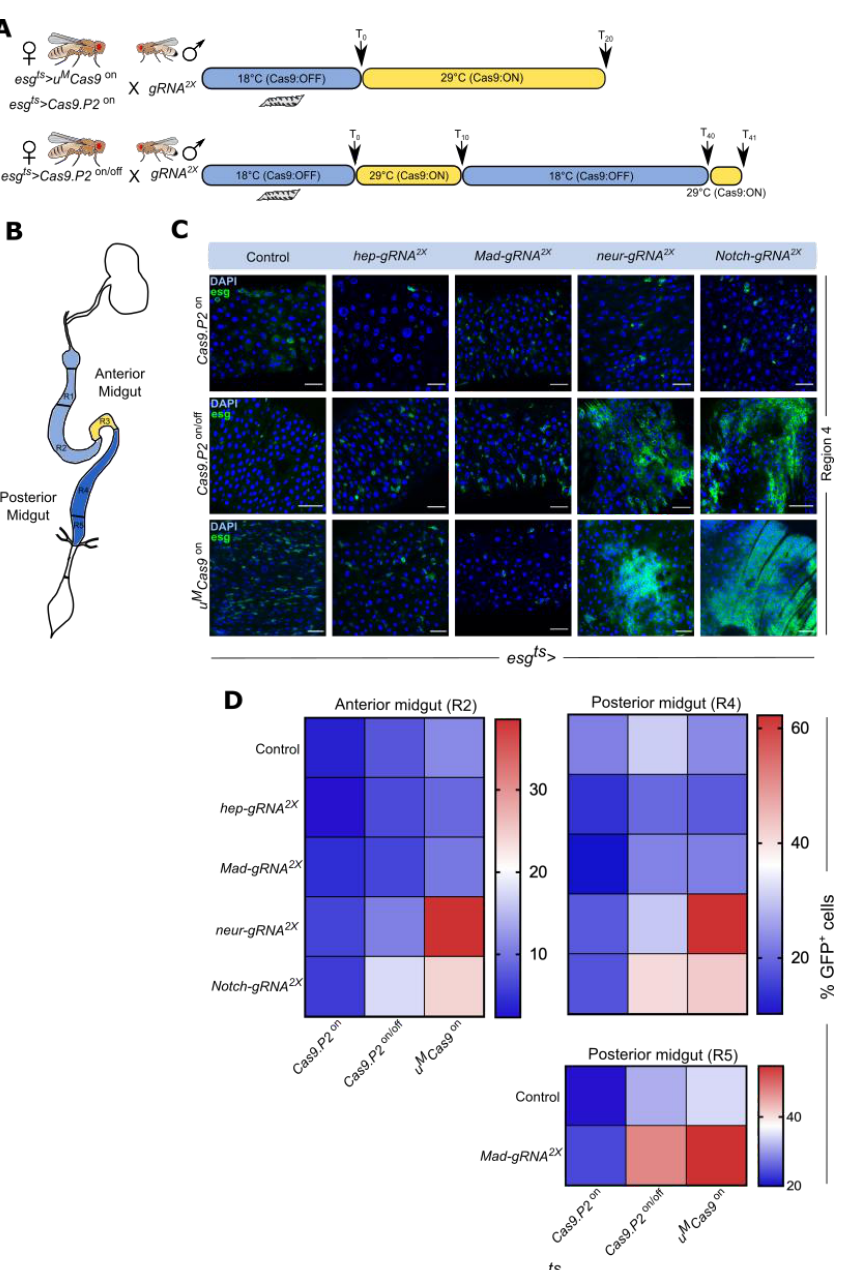
Figure 3. Both Cas9.P2 on/off and u M Cas9 on are effective at inducing intestinal stem cell derived tumors. ( A ) Schematic representation of the timepoints used for experiments. Female flies expressing either Cas9.P2 on or u M Cas9 on were crossed to male flies expressing different gRNAs . The cross was main- tained at 18 °C and the progeny were raised under these conditions during their development. After adult progeny emerged (T 0 ), they were shifted to 29 °C continuously for 20 days to induce the esg ts expression system, which allows for both Cas9 and gRNAs to be expressed in ISCs/EBs. Since high expression of Cas9.P2 is toxic, we also devised an on/off strategy ( Cas9.P2 on/off ), whereby adult prog- eny were initially shifted to 29 °C for 10 days (T 10 ), then to 18 °C for 30 days (T 40 ) and finally at 29 °C for one day (T 41 ). ( B ) Schematic representation of the intestine with different regions highlighted. ( C ) Confocal images of the R4 regions of the intestine in flies expressing Cas9 and gRNAs against hep , Mad , neur , and Notch . Notice that for Cas9.P2 on/off and u M Cas9 on with gRNA against neur and Notch resulted in massive proliferation of ISCs/EBs. ( D ) Heatmap showing the average percentage of GFP + ISCs/EBs after using different Cas9 enzymes f or perturbations. Scale bar: 30 μm.